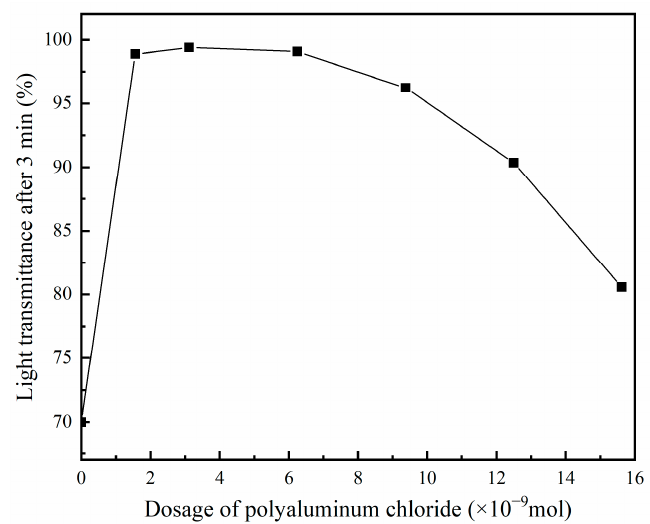
Figure 3. Effect of combined use of PAM and polyaluminum chloride (6.66 × 10 − 10 mol) on sedimentation.